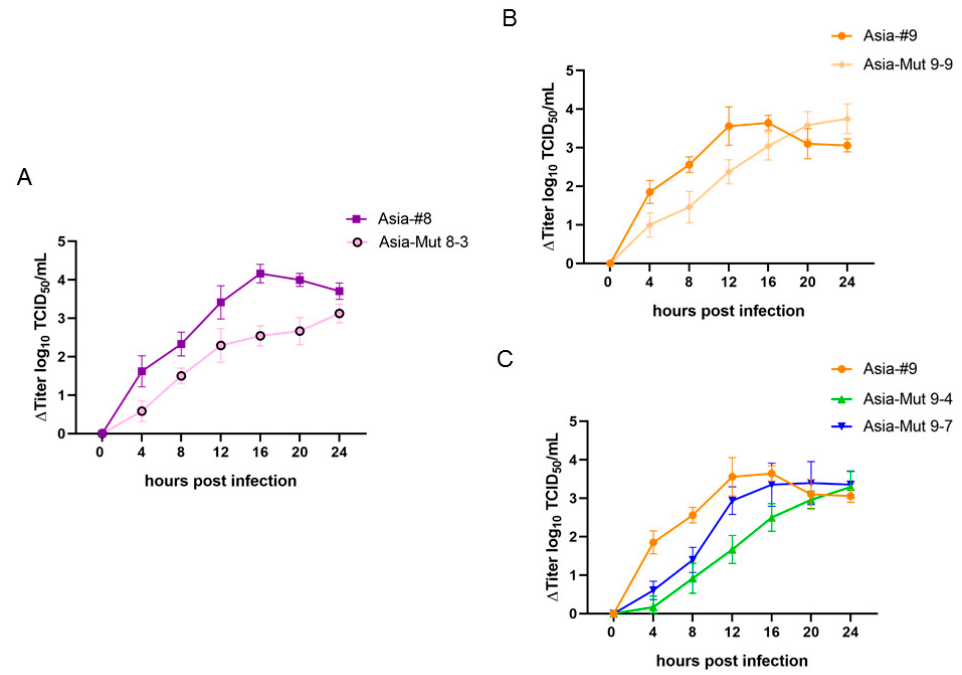
Figure 1. Growth curves in BHK-2P cells of the recombinant viruses, Asia-Mut 8-3 ( A ), Asia-Mut 9-9 ( B ), Asia-Mut 9-4 and Asia-Mut 9-7 ( C ) in comparison to the corresponding passage-derived strains Asia-#8 and Asia-#9. All values are plotted relative to the titer at 0 hours to emphasize the change in virus titer over time.